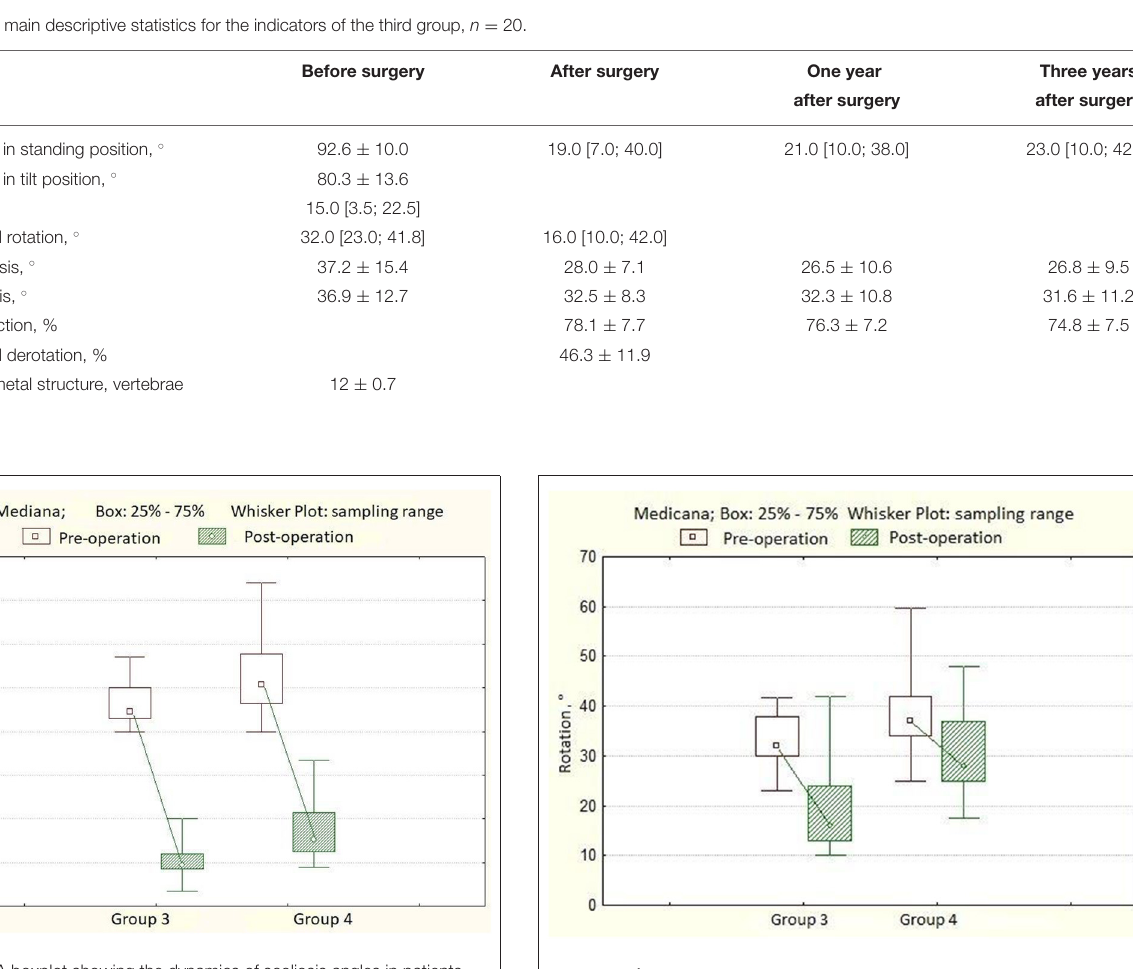
FIGURE 4 | A boxplot showing the dynamics of the angles of rotation of the apical vertebra in patients from groups 1 and 2.